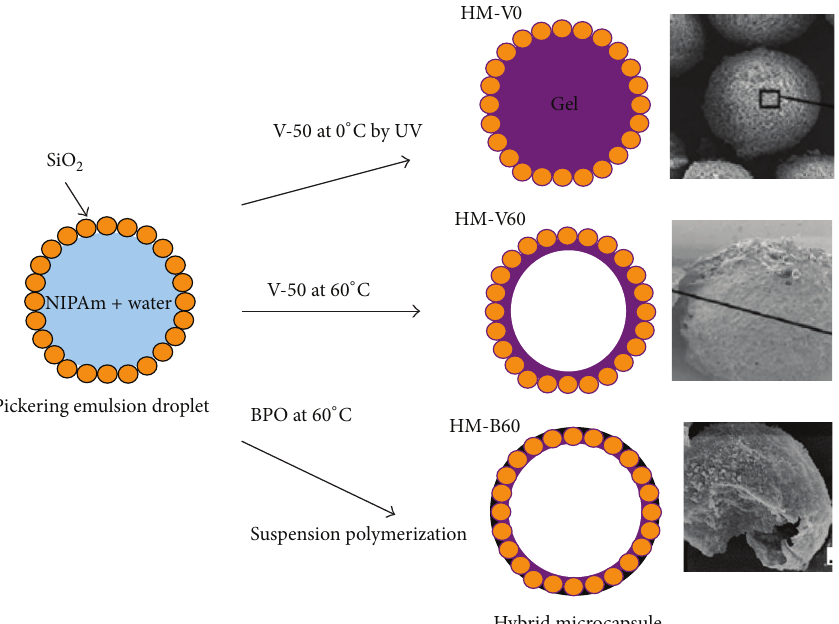
Figure 6: Schematic illustration of the fabrication of hybrid microcapsules at different polymerization conditions (reproduced from [81], with permission from